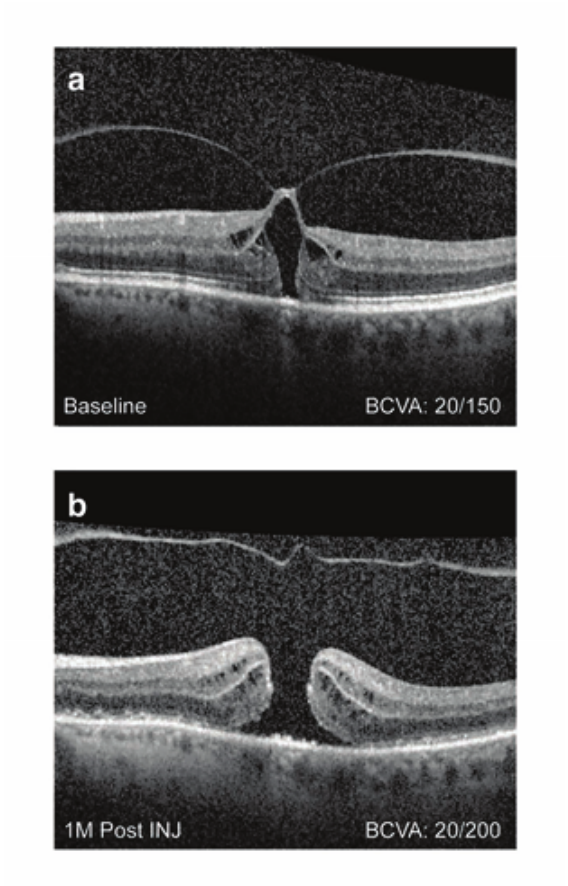
Figure 2. Case 2. Spectral domain optical coherence tomography of a 63-year-old female showing VMA with FTMH. (A) Baseline visit. No ERM or presence of SRF; BCVA 20/150. (B) One month post treatment. VMA released, but macular hole remained open, with the base enlarging to 1323 𝜇 m. BCVA decreased to 20/200. BCVA, best-corrected visual acuity; ERM, epiretinal membrane; INJ, injection; M, month; SRF, subretinal